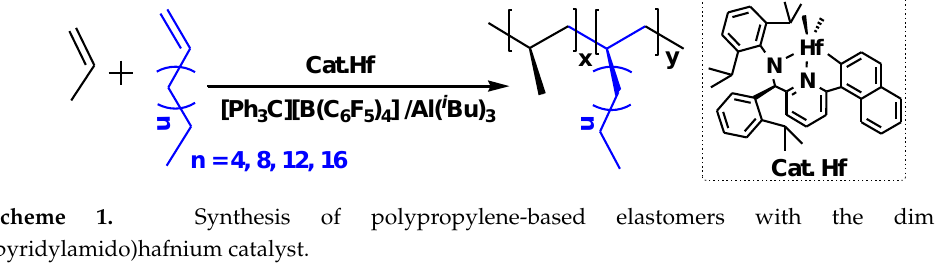
Scheme 1. Synthesis of polypropylene-based elastomers with the dimethyl (pyridylamido)hafnium